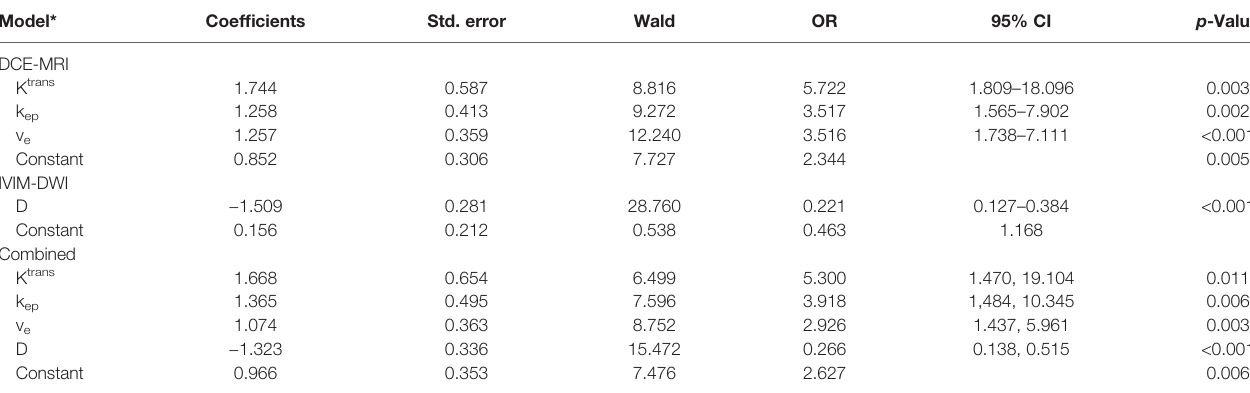
TABLE 3 | Model of DCE-MRI and IVIM-DWI quantitative parameters and their combination in predictive impact on response to NCT by multivariate logistic regression analysis. Model* Coef fi cients Std. error